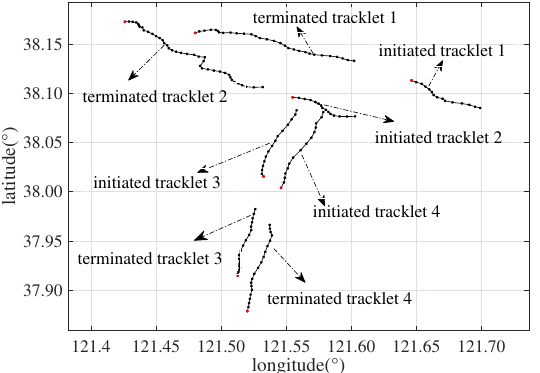
Figure 6. Tracklets from field data for the association test.